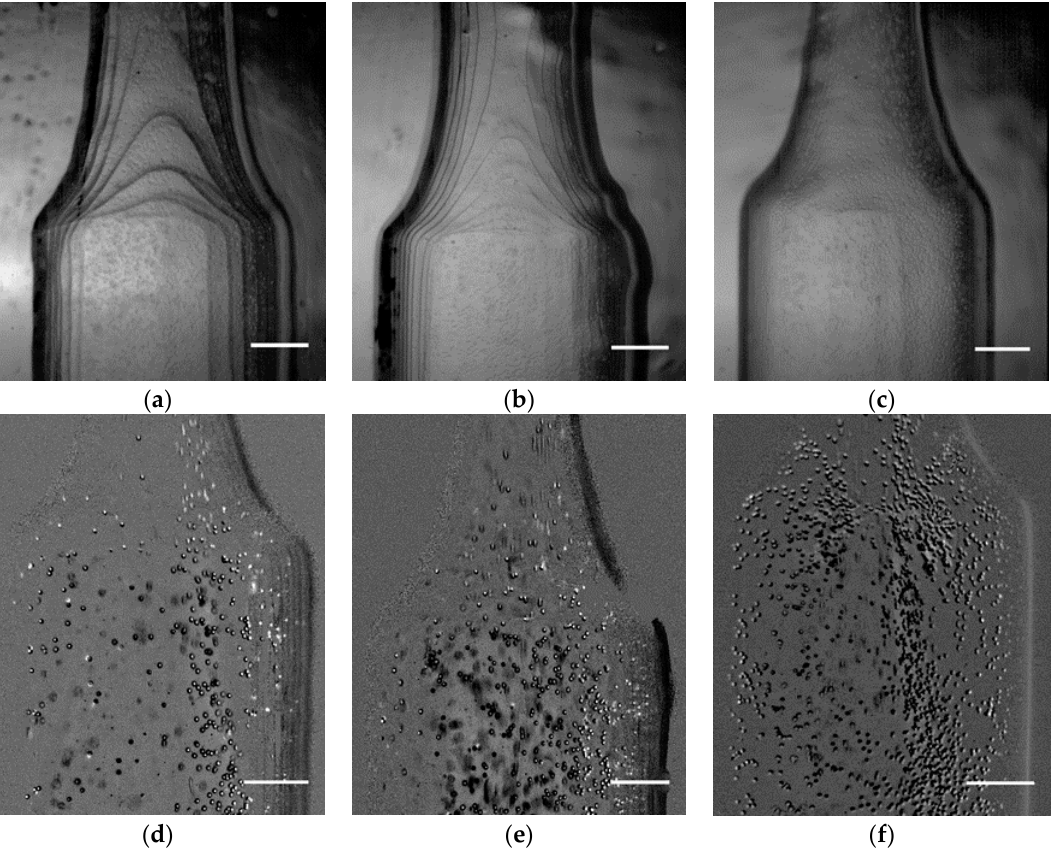
Figure 5. Images obtained for each printing resolution: ( a ) 150 μ m; ( b ) 100 μ m; ( c ) 50 μ m and the respective images with tracer particles obtained by the high-speed camera: ( d ) 150 μ m; ( e ) 100 μ m; ( f ) 50 μ m. Scale bar, 1 mm.